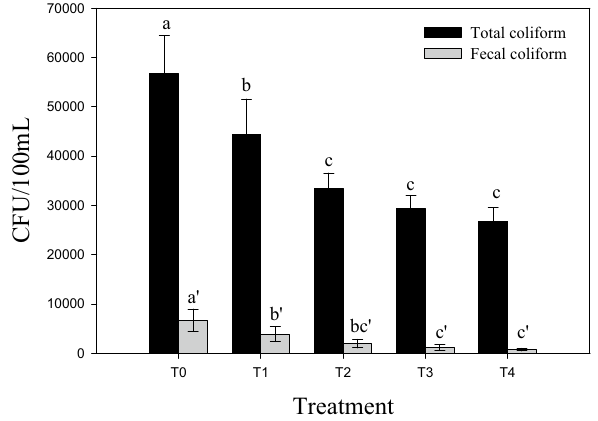
Figure 3. Total and fecal coliform in wastewater collected from each treatment unit. T 0 (untreated water), T1 (water after sedimentation unit), T 2 (water after sand & gravel beds), T 3 (water after reed + sand & gravel beds) and T 4 (water after biochar + sand & gravel beds). Similar letters indicate no significant variations among